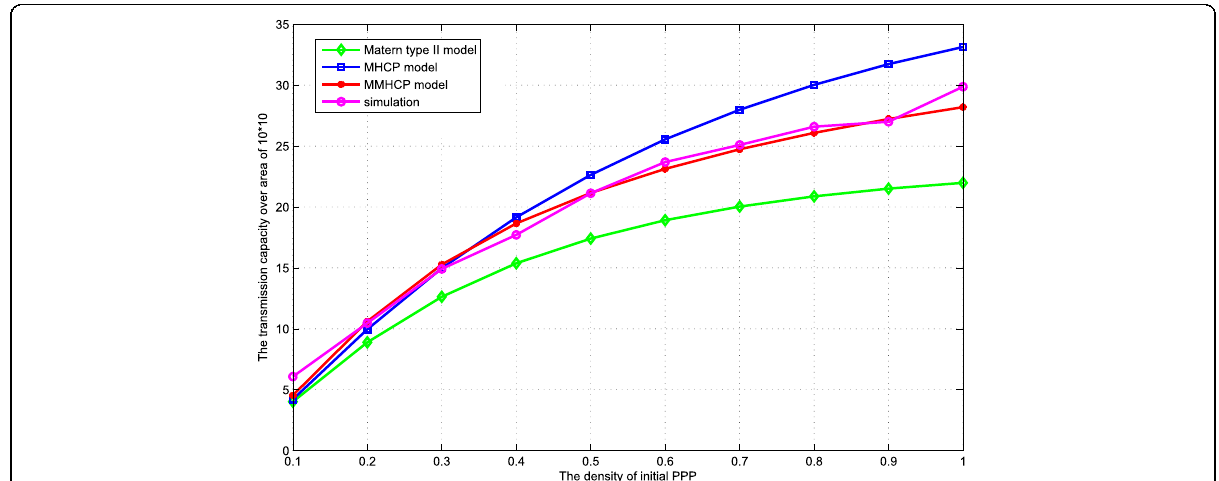
Fig. 13 Transmission capacity for different initial PPP